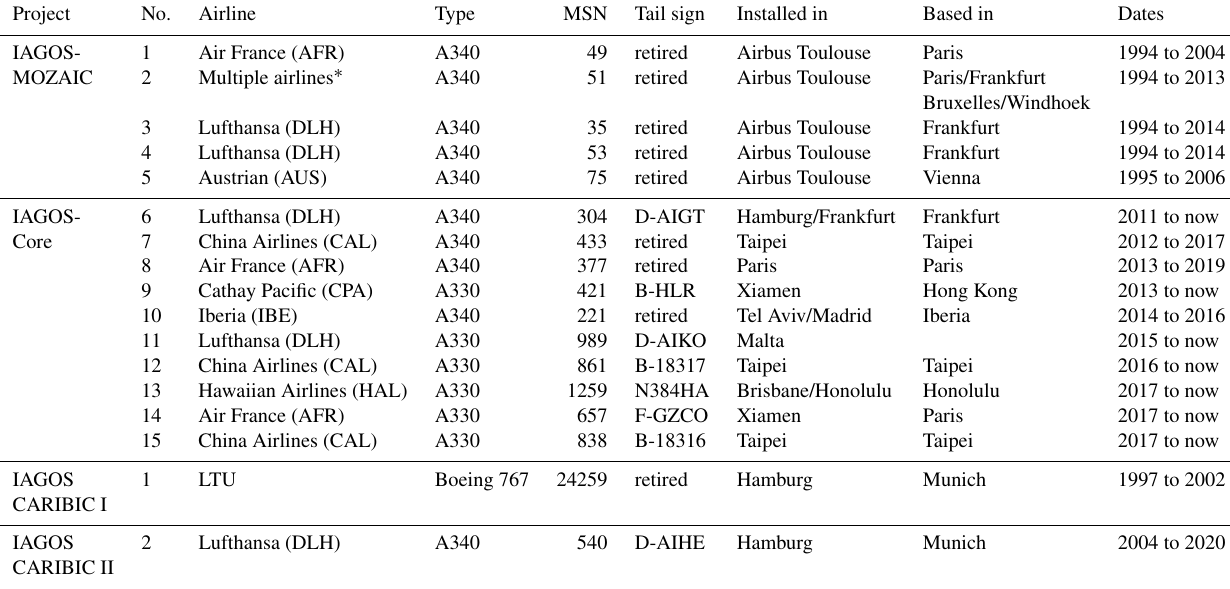
Table 2. List of the aircraft manufacturer serial number (MSN) equipped with the IAGOS-MOZAIC, IAGOS-Core and IAGOS-CARIBIC systems since